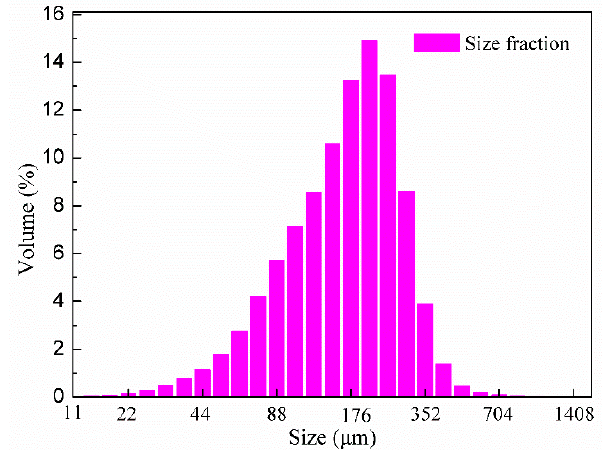
Figure 1. Laser particle size analysis of glass microspheres.